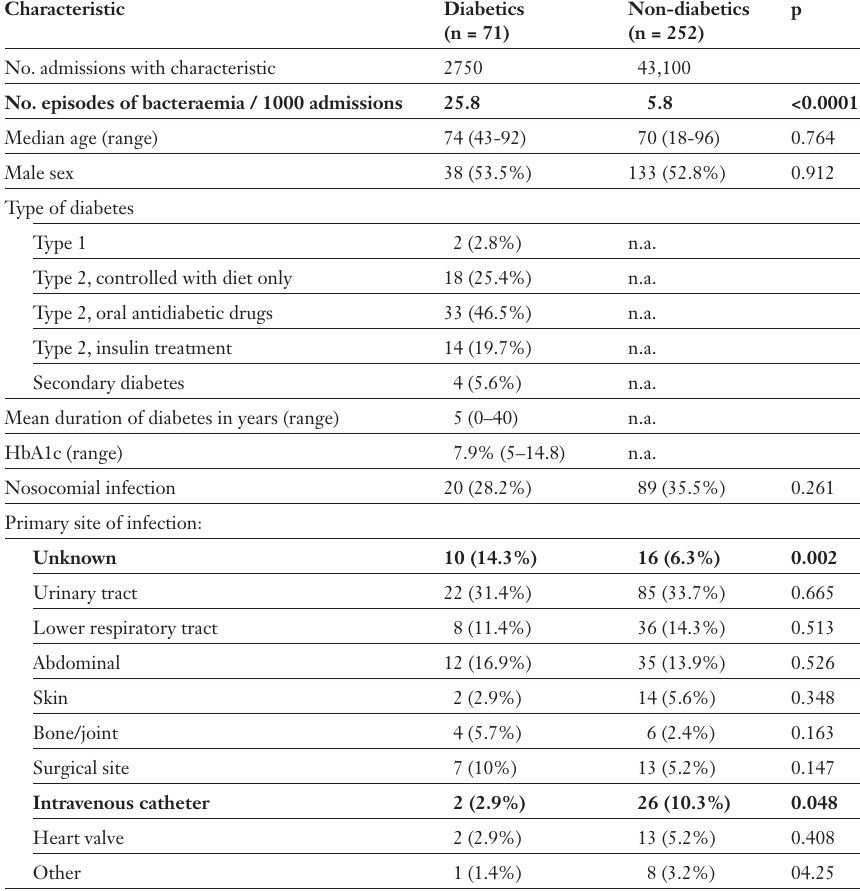
Demographics and source of blood- stream infection in 71 diabetic and 252 non-diabetic